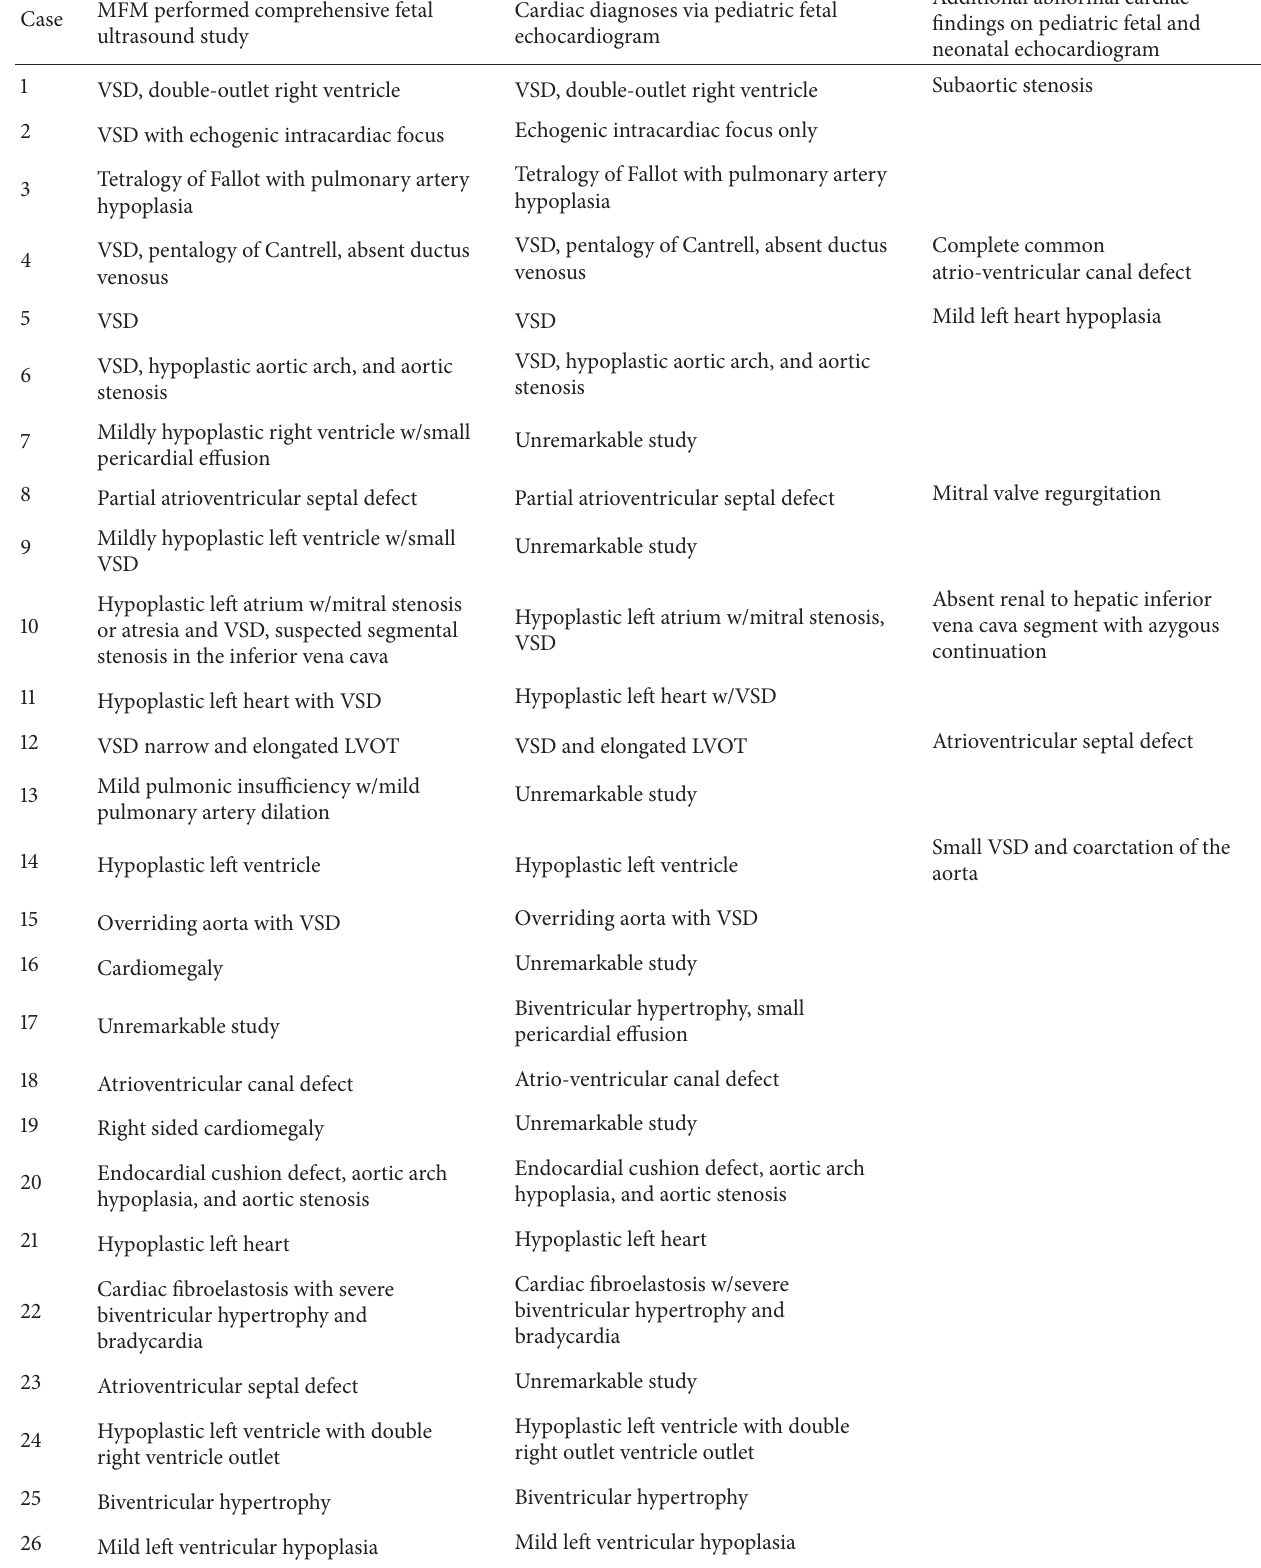
Table 4: Cardiac abnormalities detected by MFM physician versus pediatric cardiologist performed fetal echocardiogram for Group D.